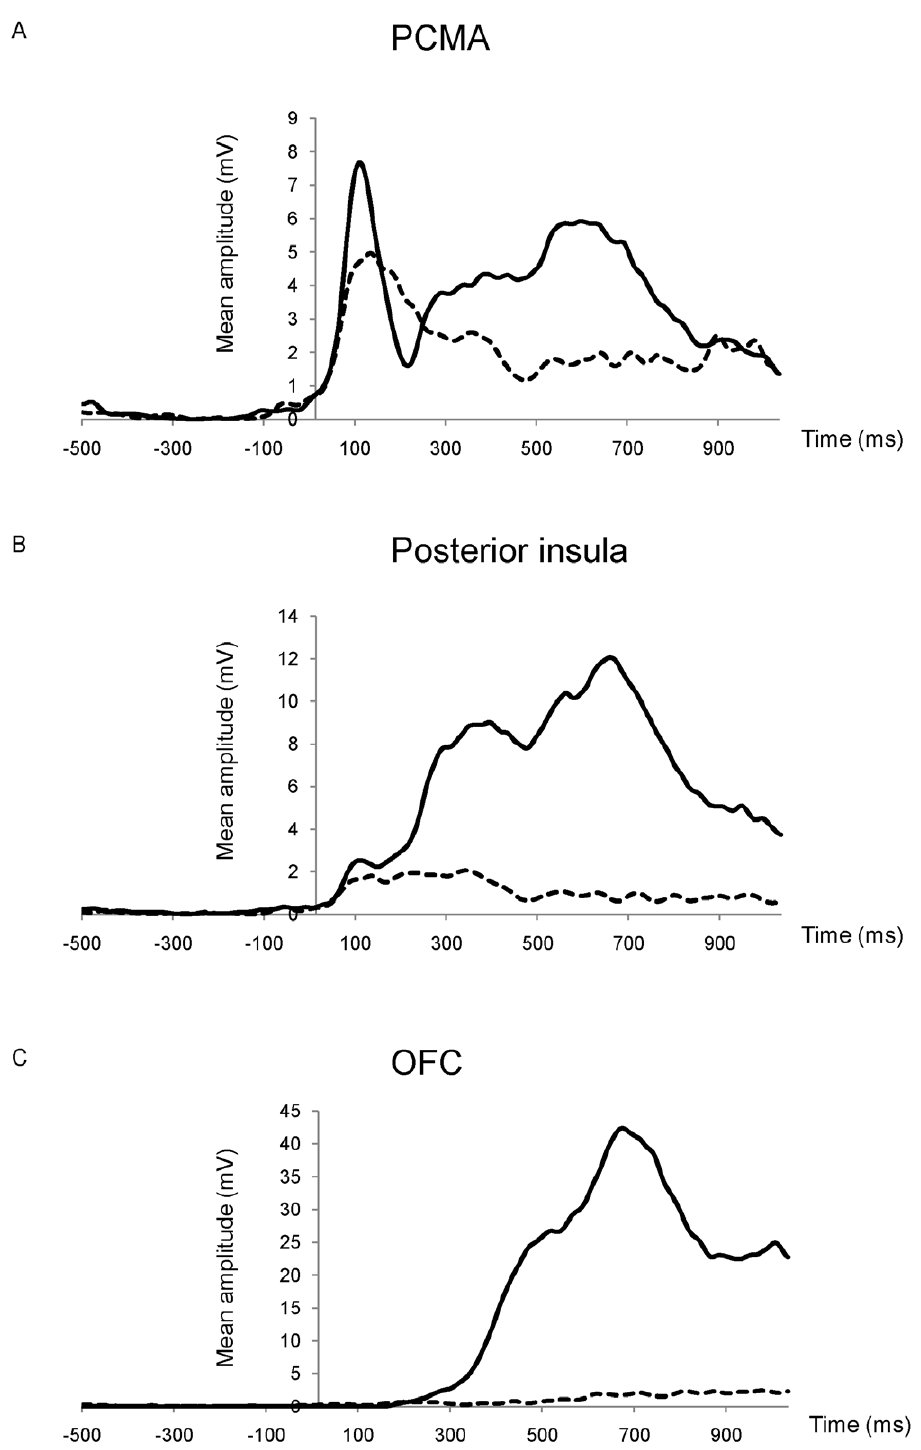
Figure 5. Time-course of activation. Mean amplitude (mV) is shown for aware (solid lines) and unaware (dotted lines) errors, separately for each of the three main ROIs. (A) left PCMA; (B) left posterior insula, and (C) right OFC. Note the increase in amplitude difference between aware and unaware errors from PCMA to insula to OFC.